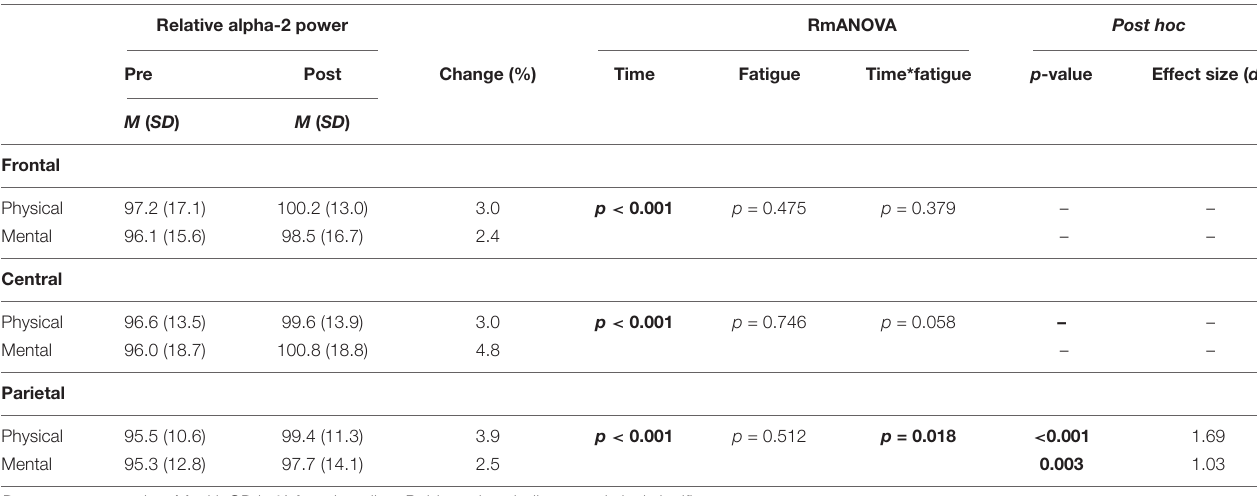
TABLE 4 | Averaged alpha-2 frequency power relative to baseline values pre and post to PF and MF within the respective ROIs as well as rmANOVA results and post hoc tests. Relative alpha-2